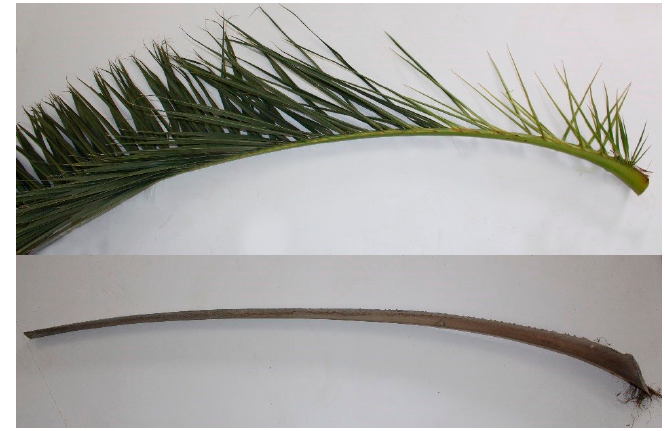
Figure 1. Frond and rachis of a palm tree.